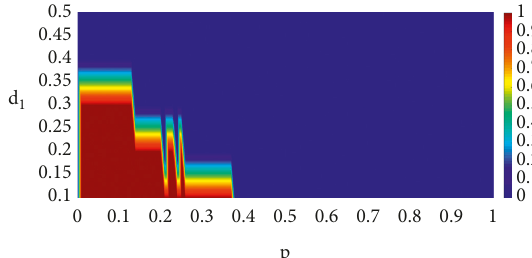
Figure 5: The region of instability about d